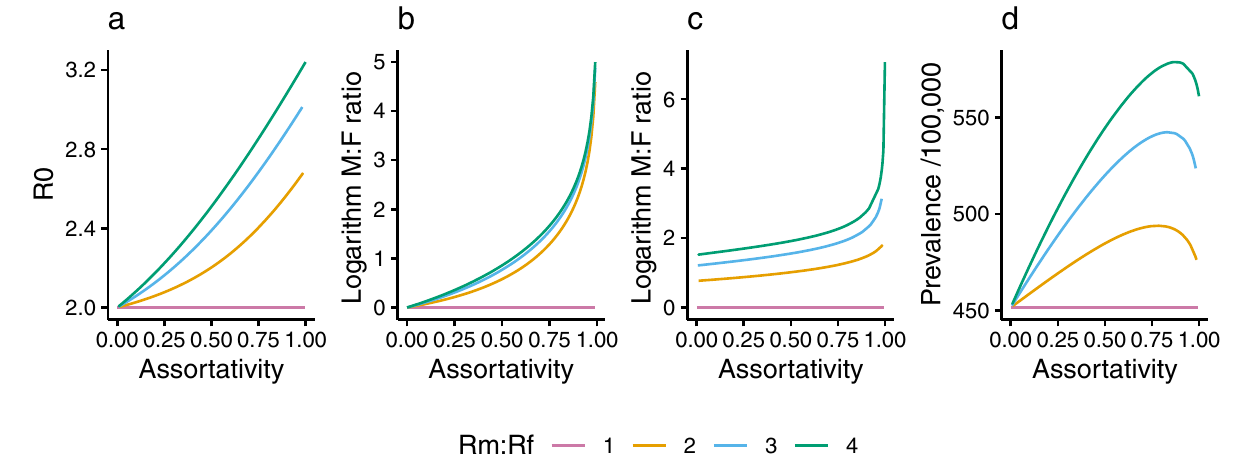
Figure 2. Influence of assortativity ( ρ ) at invasion and equilibria for different R m / R f . The effect of ρ on: ( a ) R 0 ; ( b ) M:F ratio during early exponential growth from the disease-free equilibrium; ( c ) M:F ratio in TB prevalence at endemic equilibrium; ( d ) TB prevalence at endemic equilibrium. In ( c , d ), β and α were solved to give R 0 = 2 and fix R m / R f , ρ was varied, and π = 1 . Other parameters were the means of priors in Table